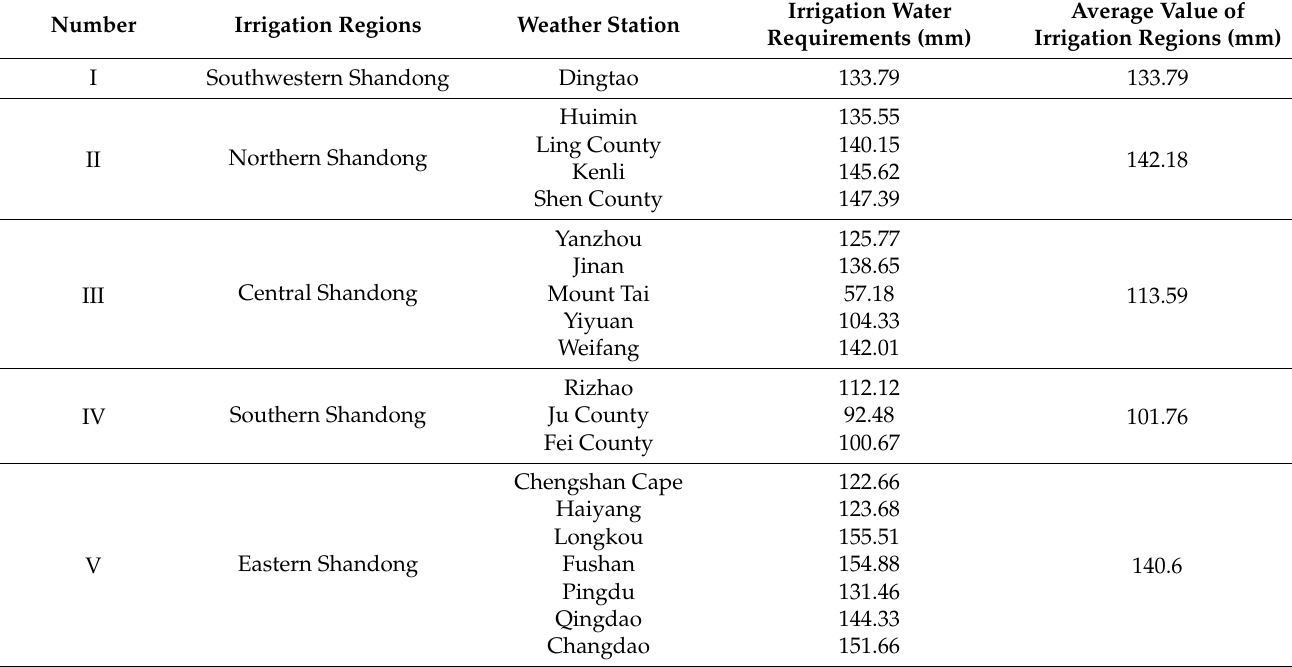
Table 3. The multi-year average irrigation water requirements of summer maize from 1968 to